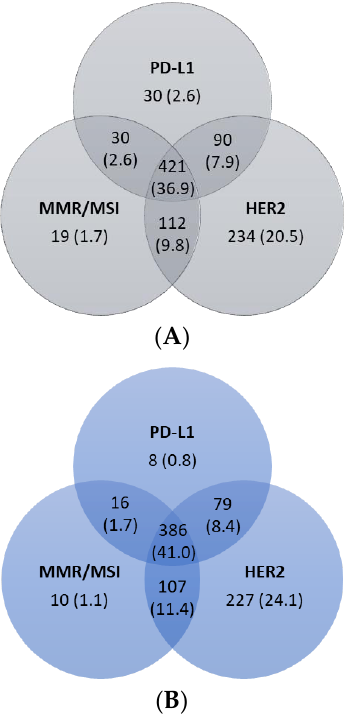
Figure 3. Biomarker testing combinations. Venn diagram depicting biomarker testing combinations for PD-L1, MMR/MSI, and HER2. A: Number (%) of patients tested for PD-L1, MMR/MSI, and HER2. B: Number (%) of patients tested for PD-L1, MMR/MSI, and HER2. HER2, human epidermal growth factor receptor 2. MSI, microsatellite instability. MMR, mismatch repair. PD-L1, pro- grammed cell death-ligand 1. ( A ) Overall (N = 1142); ( B ) patients with adenocarcinomas (N = 942) .